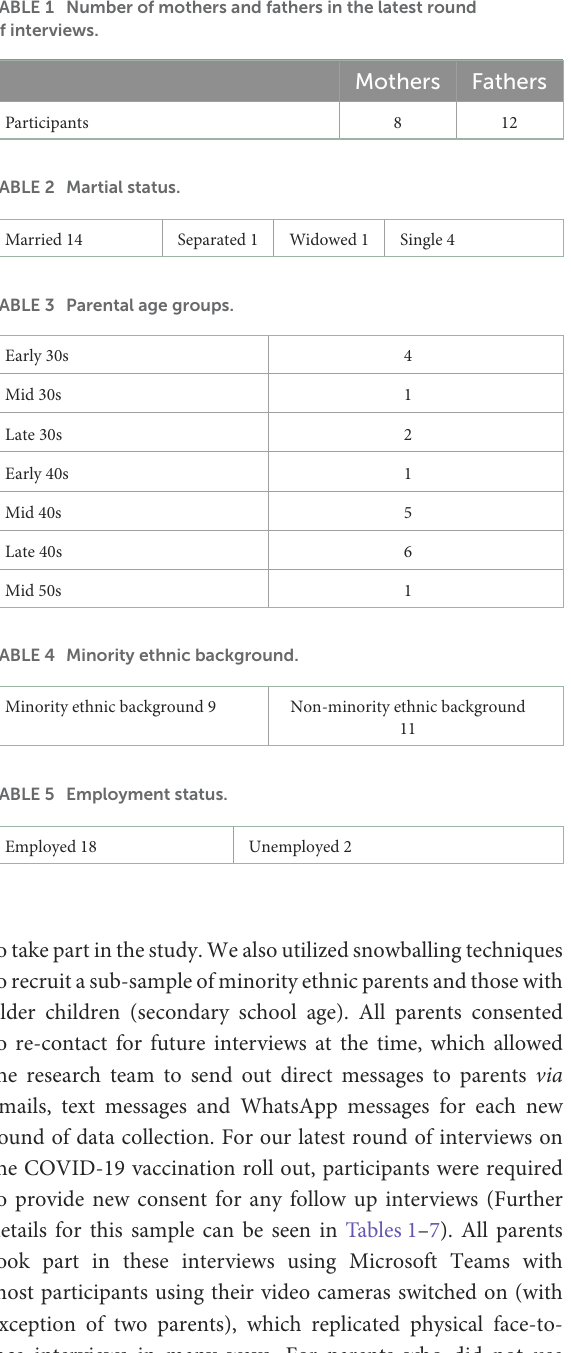
TABLE 6 Number of children in each family.